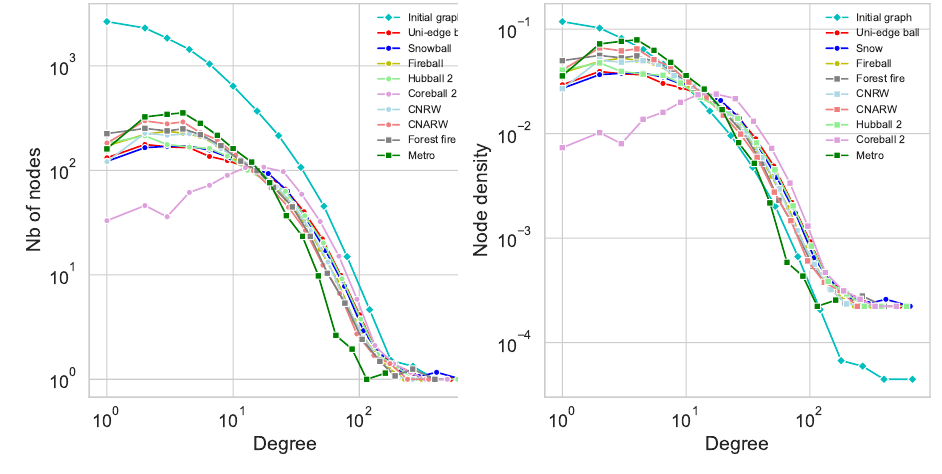
Figure 4. Degree distribution ( left ) and density ( right ) of the collected nodes on the Facebook graph. The sampling reduces the graph to 20% of its original size. The curve corresponding to the initial graph is in